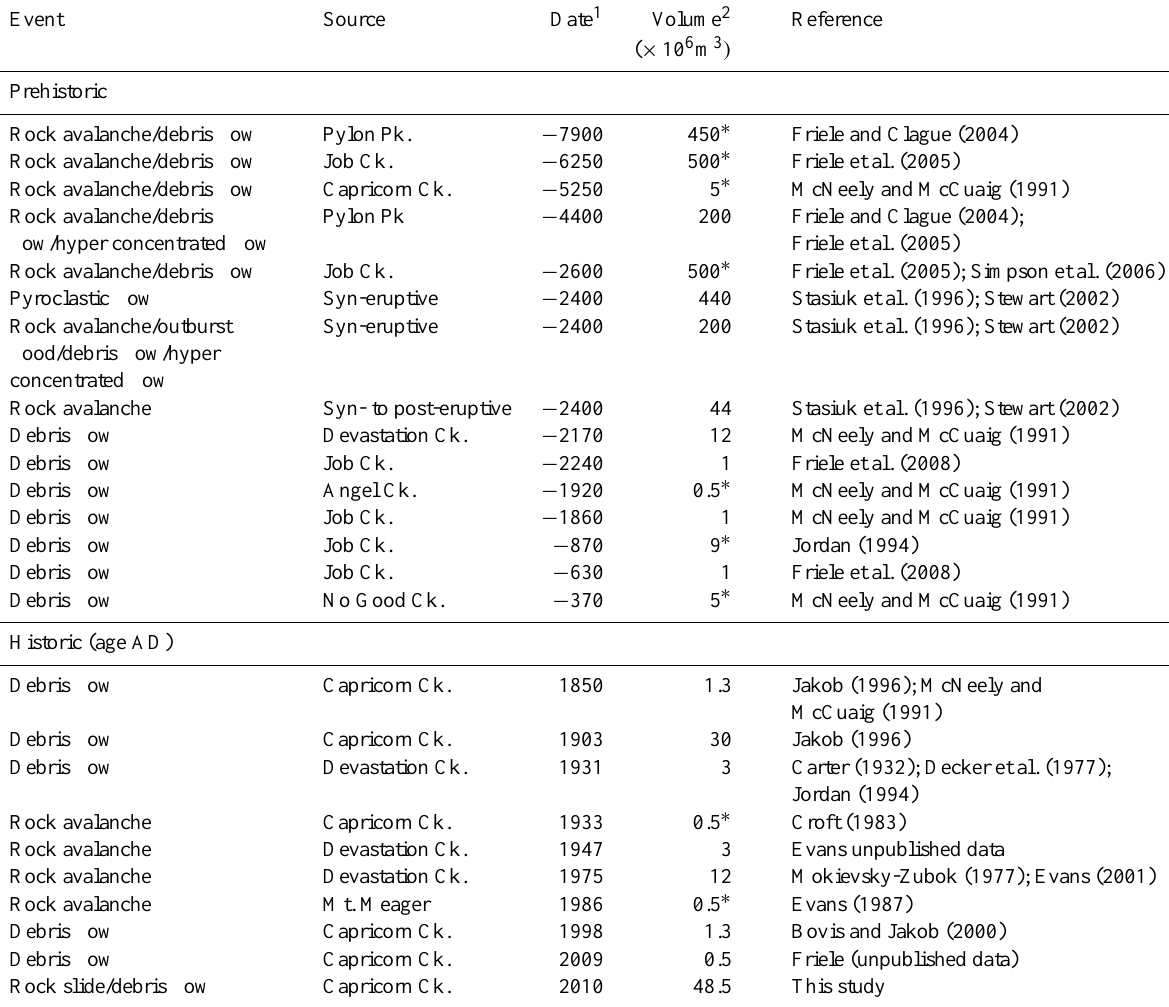
Table 1. The history of landslides ≥ 0.5 × 10 6 m 3 from the Mount Meager Complex (adapted and updated from Friele et al.,